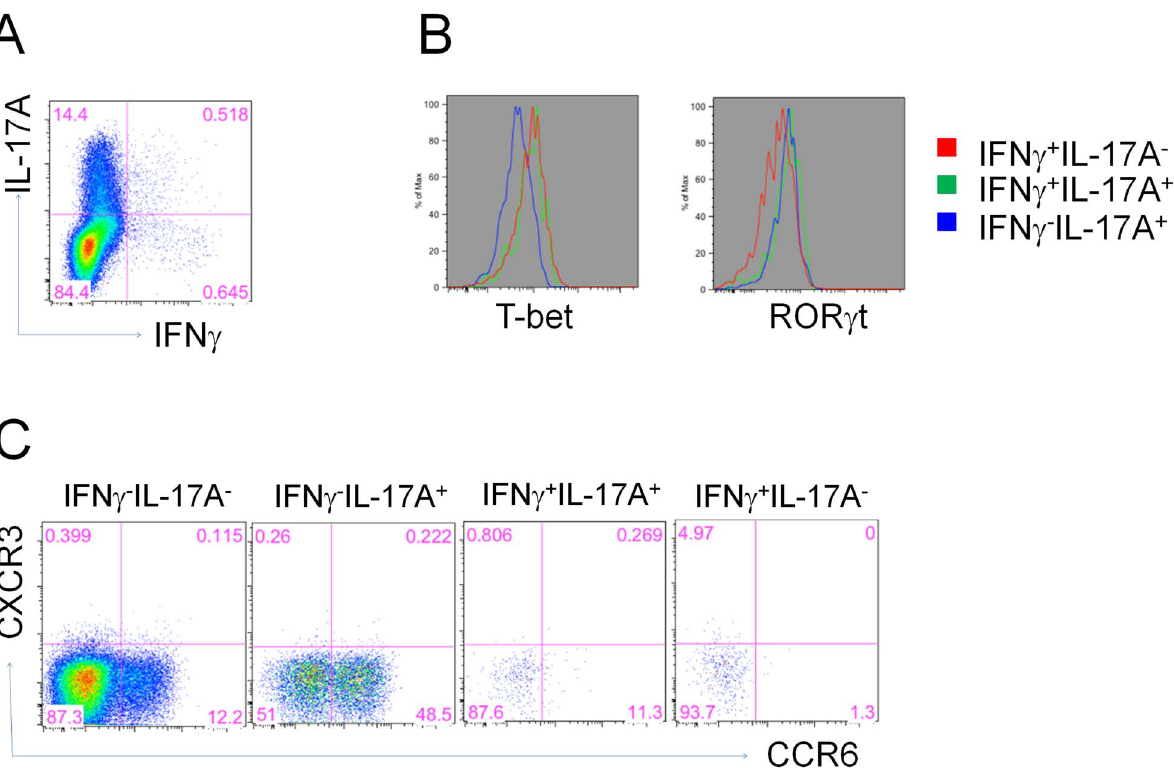
Figure 8. Heterogeneous expression of CCR6 on vaccine primed Th17 cells. 5 days post influenza challenge, lung CD4 + T cells from vaccinated mice were examined for antigen-specific IL-17A or IFN c expression (A), then gated subsets were examined for transcription factors ROR c t and T-bet levels (B) as well as CCR6 and CXCR3 expression (C).